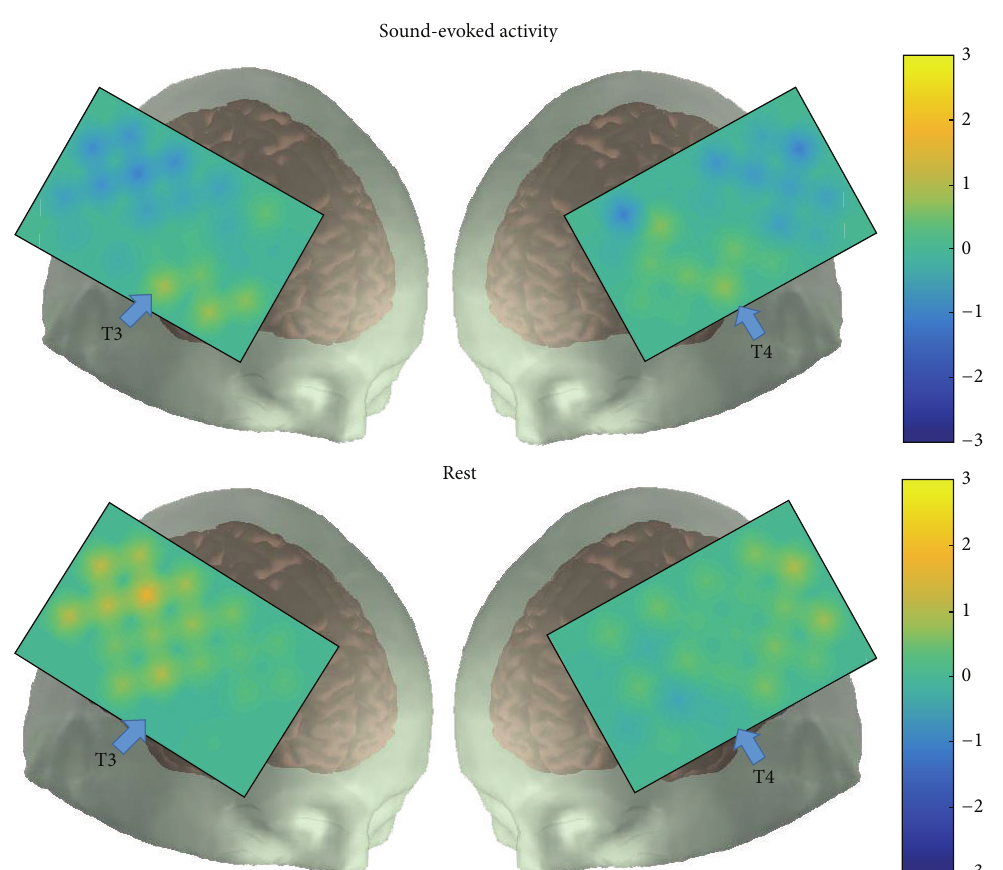
Figure 3: Sound-evoked activity (upper panel) versus responses during silence/rest (lower panel) recorded between right (left hand column) and left (right hand column) hemispheres in control brains. Localization of light emitters and detectors (as mapped in Figure 1) reveals greater activity (yellow) over auditory cortex during acoustic stimulation corresponding to ROI versus less activity over non-ROI (blue). During periods of rest (ISR) note the reversal of brain activity between ROI and